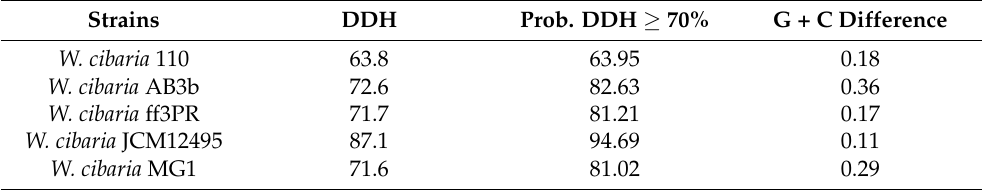
Table 2. Genetic similarity between W. cibaria W25 and other strains using Digital DDH (DNA– DNA hybridization) similarities based on the GGDC (Genome-to-Genome Distance Calculator). The recommended formula 2 was chosen for the inferred